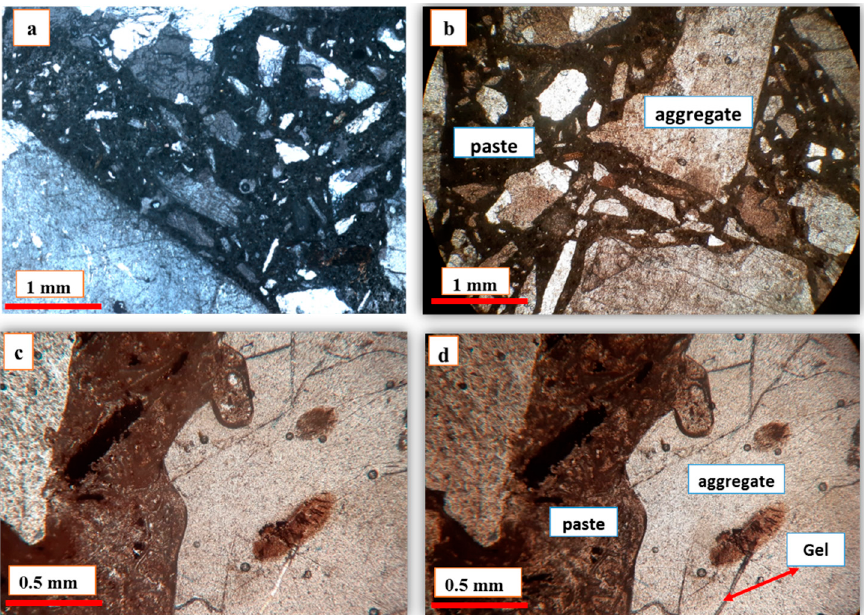
Figure 12. Optical microscopy photograph: ( a ) granite concrete after 1 month; ( b ) granite after 6 months; ( c ) rhyodacite concrete after 6 months with non-polarized light; ( d ) rhyodacite aggregate after 6 months (gel-like materials are seen in the polarized light).